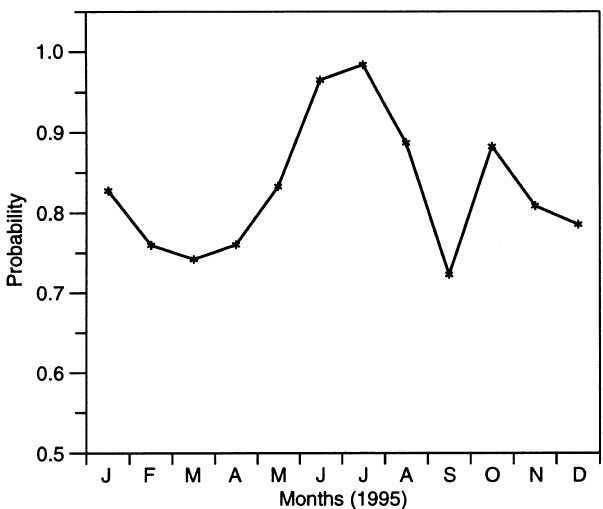
Fig. 3. Annual variation of the existing probability of the 2-day oscillation in the ionospheric plasma Table 1. Percentage of 365-h intervals over an altitude range from 170 to 220 km, for which the probability P of existence of spectral peaks in the periodic range from 42 to 56 h is located between the given limits of probability Altitude (km) 170 180 190 200 210 220